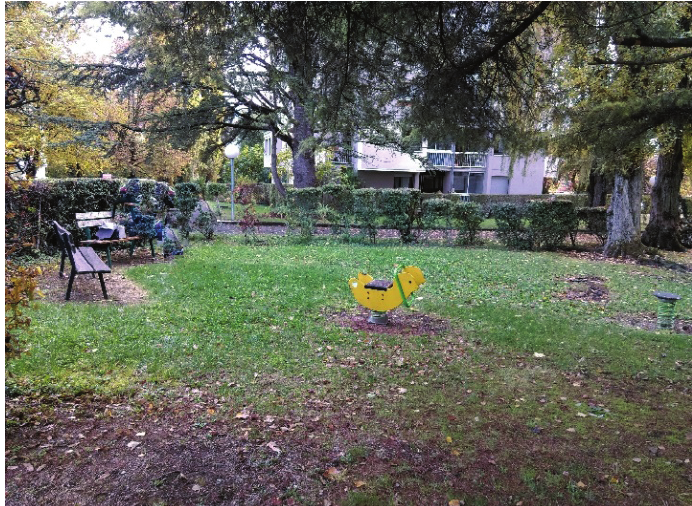
Figure 4. The picture of playgrounds with benches of sector 2 (picture by student A.